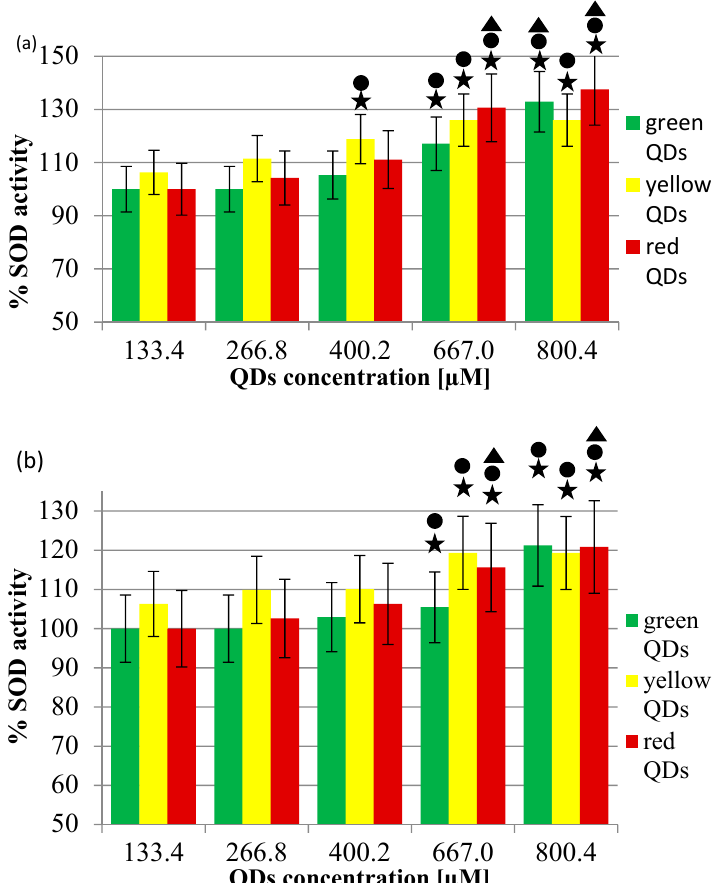
Figure 4. Changes in SOD activity, in the presence of MSA-capped CdTe QDs, after 30 min of preincubation at 30 ◦ C: ( a ) raw data; ( b ) data after correction by % of QD interference. The activity of SOD without QDs accounted for 100%. The asterisk marks a statistically significant difference compared with the activity of SOD in the presence of a 133.4 µ M QD concentration ( p < 0.05) . The circle marks statistically significant differences compared with the activity of SOD complexes in the presence of a 266.8 µ M QD concentration ( p < 0.05). The triangle marks statistically significant differences compared with the activity of complexes in the presence of a 400.2 µ M QD concentration ( p < 0.05).